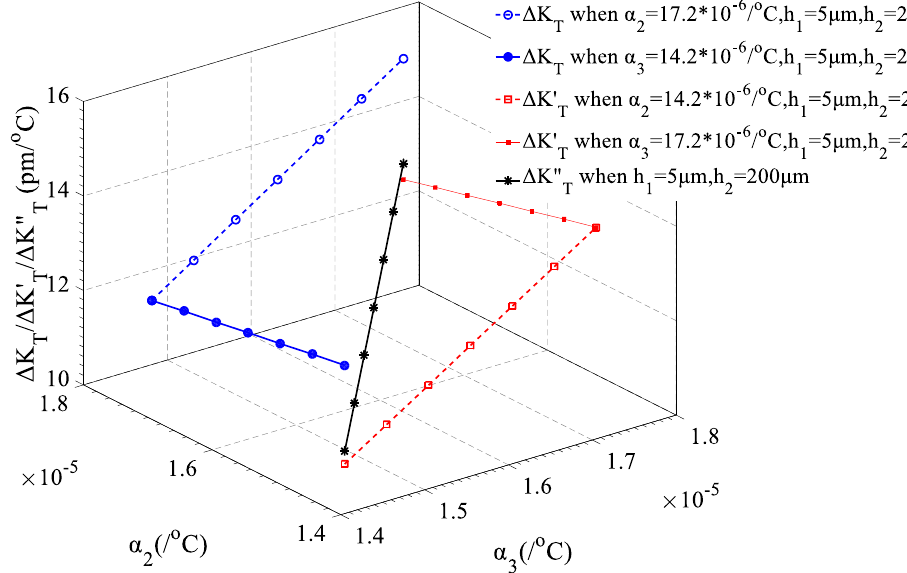
Figure 12. Effects of the coating thermal expansion coefficient on Δ K T , Δ K ′ T and Δ K ′′ T .